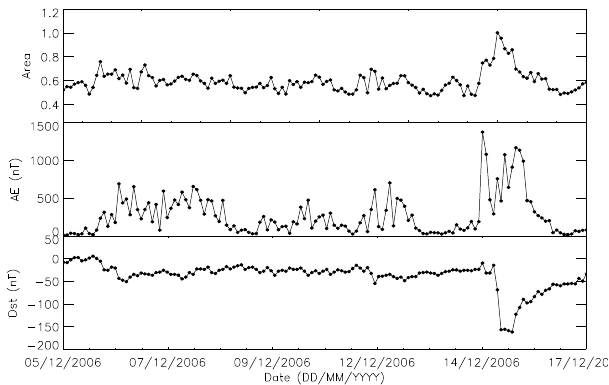
Figure 12. The variations of the area and the AE and Dst indices during 21–30 January 2012. The black dots represent the selected time to be calculated and the y axis of top panel has been normal- ized.